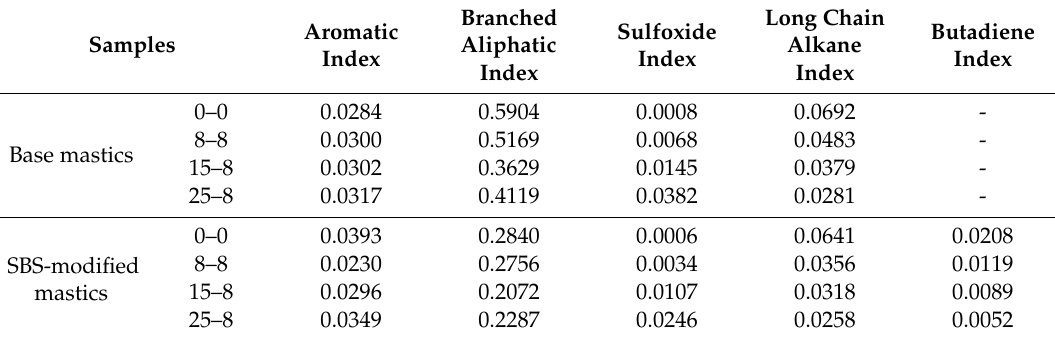
Table 6. Functional group indexes of the